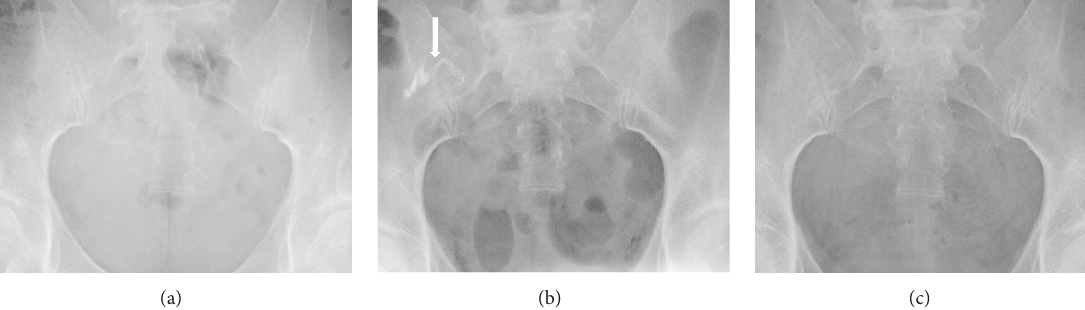
Figure 1: Abdominal X-ray test. (a) Preoperative X-ray test. Findings were within normal limits. (b) Postoperative X-ray test. A cord-like material was captured in the lower right abdomen. (c) X-ray test one month after operation. The cord-like material disappeared.